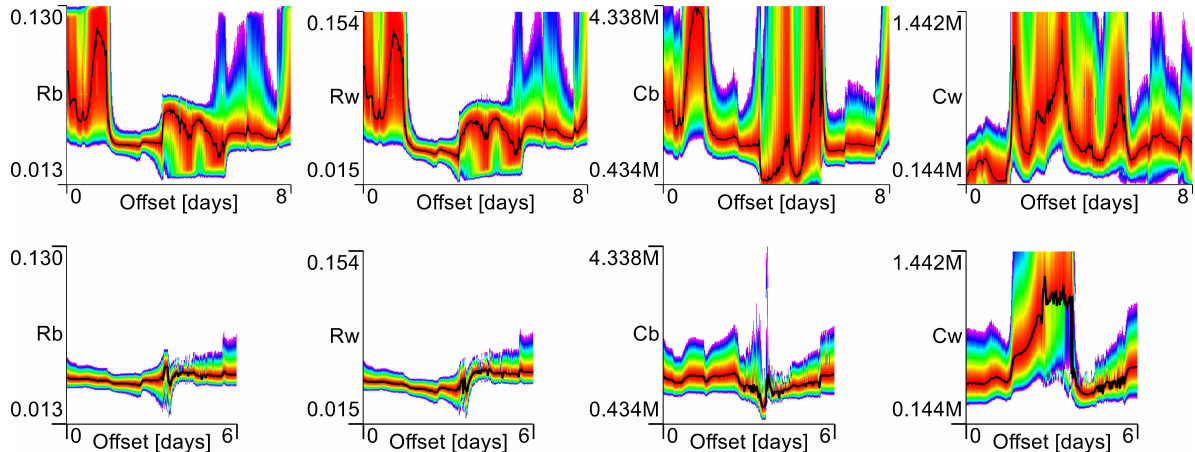
Figure 23: Consistency of dynamic information for the R2C2 model. The top four plots show the results of applying PL1 to a moving window of length 96 (2 days), while the lower four plots use a window length of 192 (4 days).